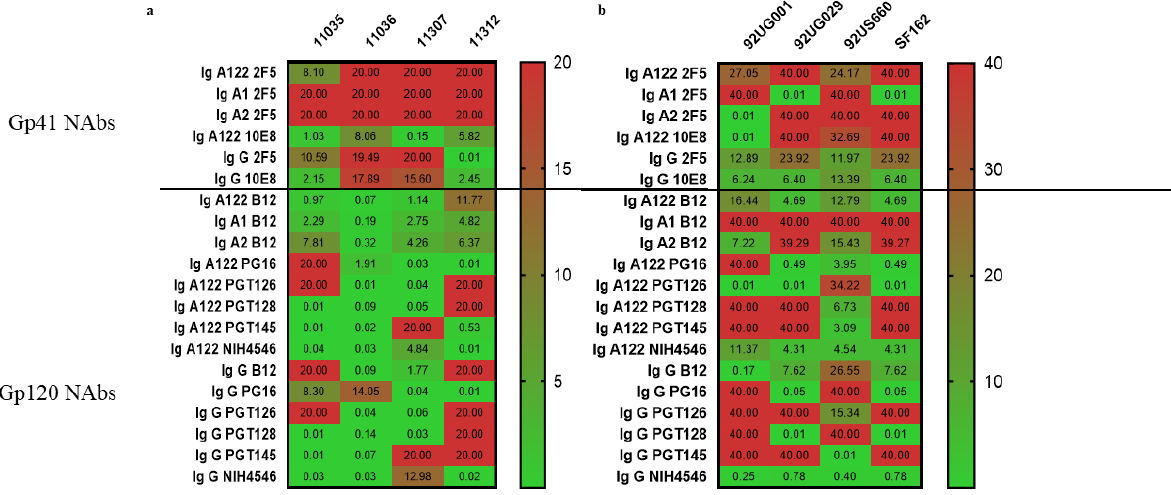
Figure 3. Neutralizing activity of bNAbs depend also on their isotypes and their specificity. Heatmap of EC50 (µg/mL) values obtained for neutralization for all tested antibodies using: ( a ) TZM-bl cells and pseudovirus or ( b ) PBMCs isolated from healthy donors and primary isolates. Numbers indicate the geometric mean values of results from duplicates of at least two independent experiments (n = 4). A 2-way ANOVA with Tukey’s multiple comparisons was used to compare EC50s from all the antibodies per virus.